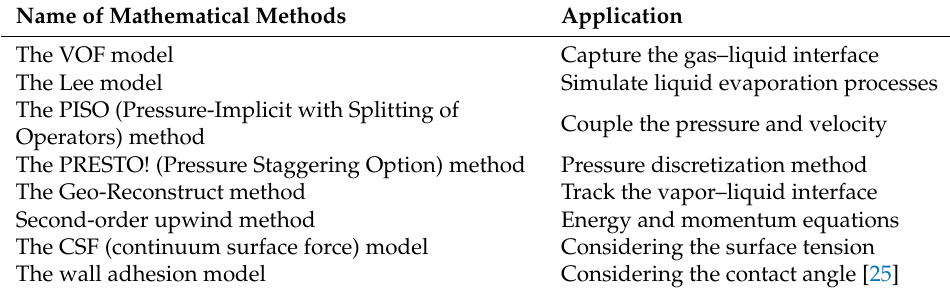
Table 5. Setting of the mathematical methods.